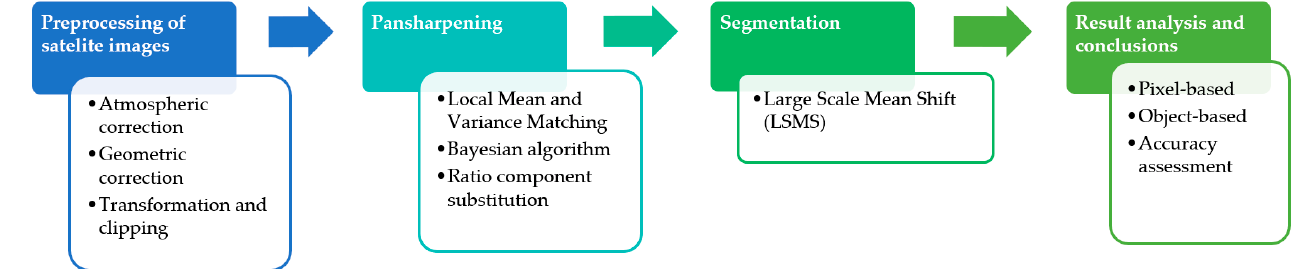
Figure 2. Research workflow of tree species classification using pansharpened very high spatial resolution satellite im- agery.